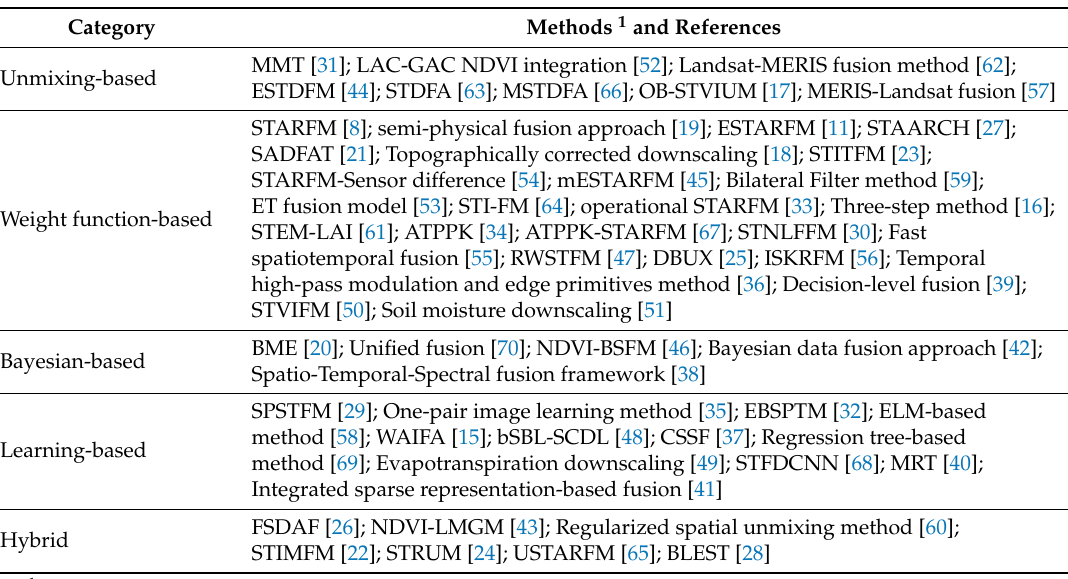
Table 3. Categories of the existing spatiotemporal data fusion